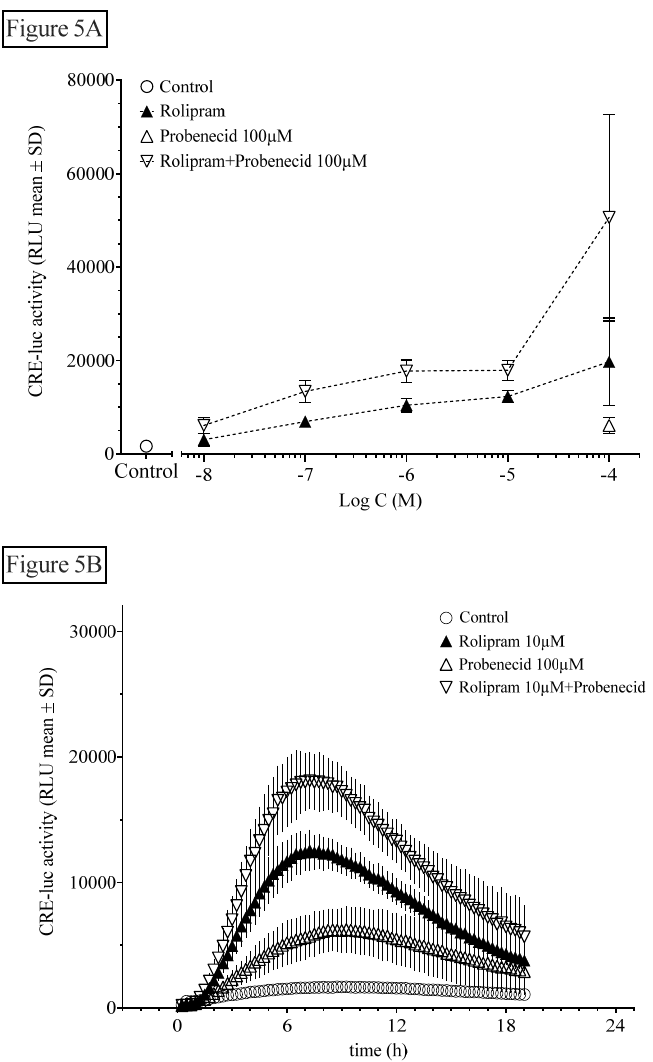
Figure 5. The organic anion-exchanger inhibitor probenecid further elevates rolipram-induced HT22CREluc activity. ( A ) HT22CREluc activity, elevated dose-dependently by the PDE selective inhibitor rolipram, was further enhanced by co-application of a single dose of the OAE inhibitor probenecid (100 µM). Mean values with standard deviation (mean ± SD) of four repetitions ( N = 4) are shown. ( B ) Time-resolved curve with probenecid (100 µM), rolipram (10 µM), and the combination of both in comparison to control (untreated) levels (mean ± SD; N = 4). Note the later onset and maximum of HT22CREluc activity induced by probenecid application (~9 h) in comparison to rolipram (~7 h). All data are from the Centro luminometer.